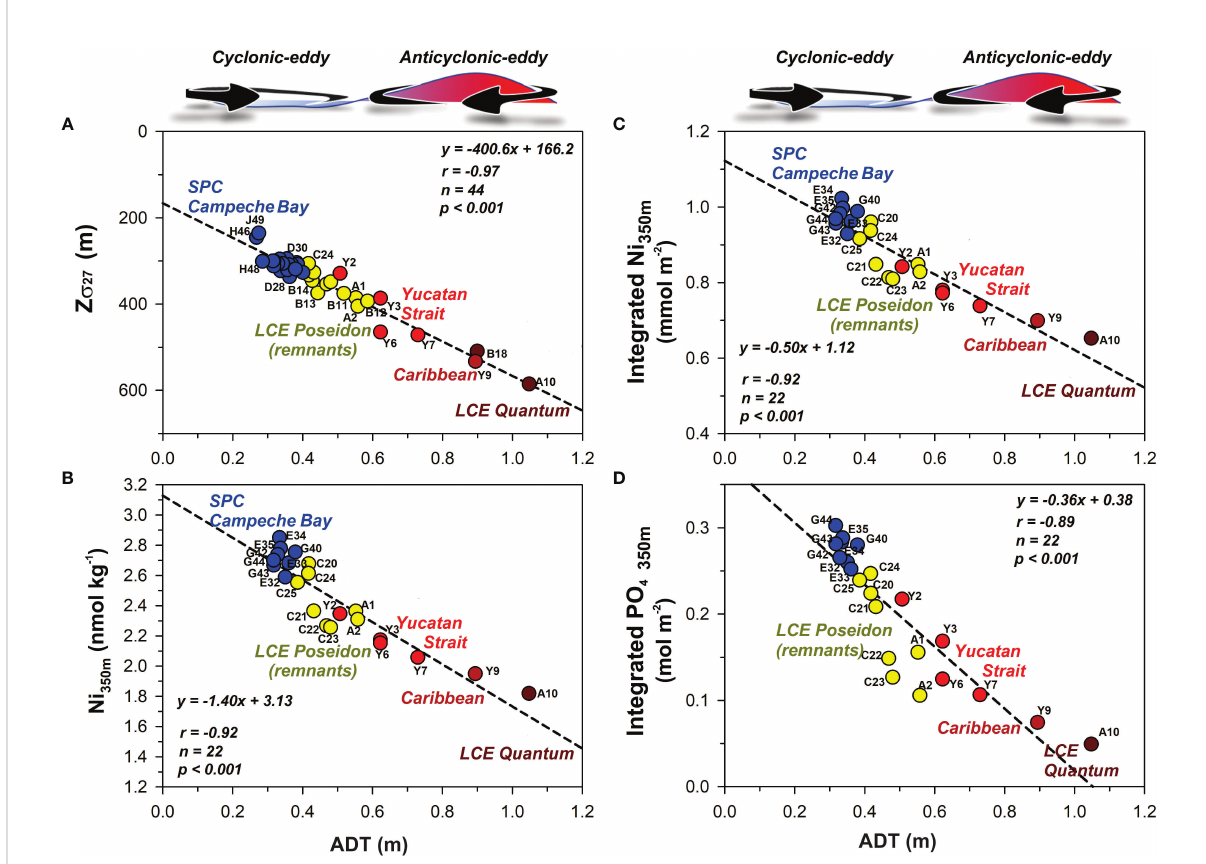
FIGURE 8 Relationship between the (A) absolute dynamic topography (ADT) and depth of the Tropical Atlantic Central Water core (TACWc), de fi ned by the potential density anomaly of 27 kg m -3 (Z s Q ). (B) ADT vs dissolved Ni concentration at the 350 m depth horizon (Ni 350m ). (C) ADT vs the integrated concentration of dissolved Ni and (D) ADT vs the integrated concentration of PO 4 in the upper 350 m of the water column. The symbols in each panel are colored to identify the sampling stations within the three contrasting regions observed during the XIXIMI-6 cruise: semi-permanent cyclone (SPC) in Campeche Bay (blue); remnants of Loop Current eddy (LCE) Poseidon (yellow); and Loop Current (LC) + LCE Quantum (red). Dashed lines represent the linear fi t between each pair of